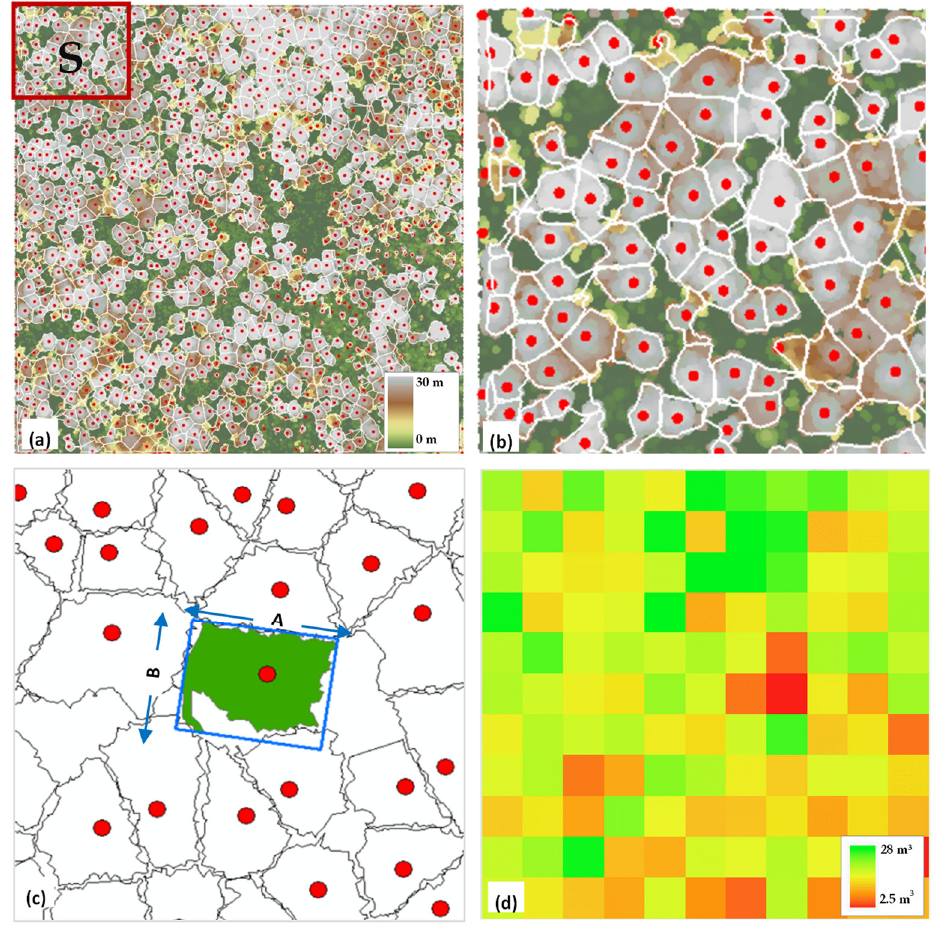
Figure 4. Generating reference stem volume data over a sampled plot. ( a ) Sample aboveground level airborne lidar data overlain with automatically detected trees (red points) and their crown segments (white outlines). ( b ) Detailed view of site S in ( a ) of detected trees and their crown segments. ( c ) Estimating crown diameter from fitted bounding box. Crown diameter estimated as the average of dimensions A and B. ( d ) Gridded stem volume in cubic meters over a plot produced using airborne lidar tree-level measurements and stem volume taper equations.